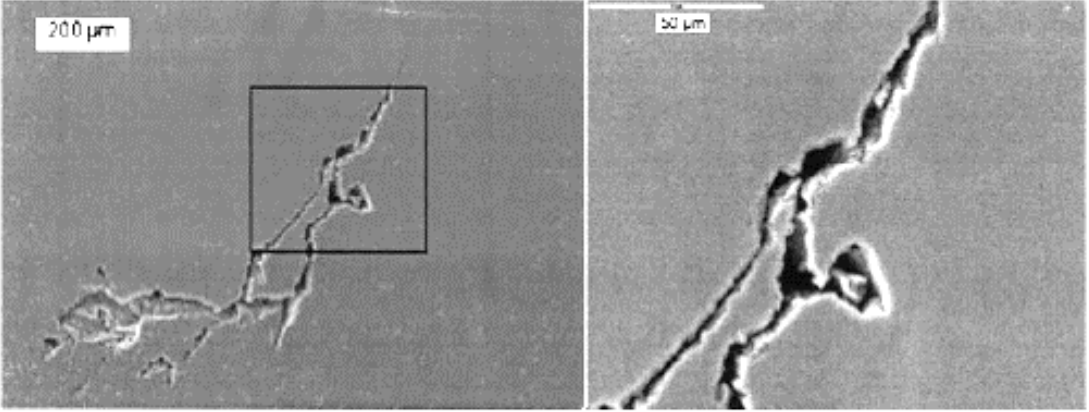
Figure 2. A folded-over surface oxide film (bifilm) on a polished surface in an Al-7%Si-Mg casting Reprinted with permission from ref. [7]. Copyright 2022 Elsevier. ( a ) the entrained films ( b ) the square in (a) magnified to show the double nature of the film..